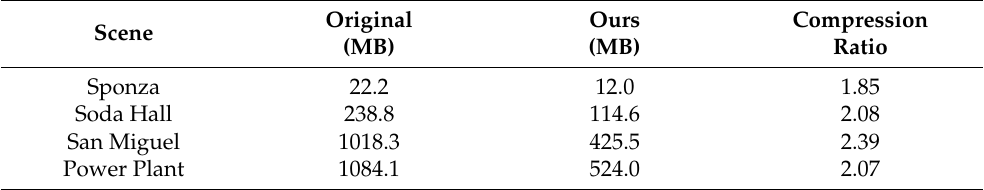
Table 6. Size reduction effect by the presented scene compression